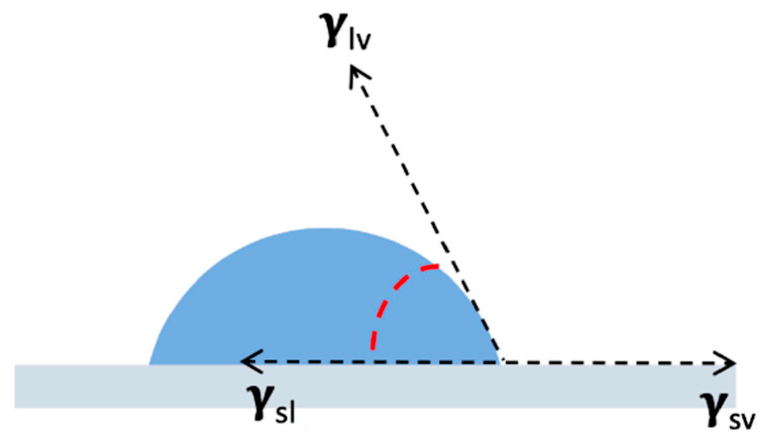
Figure 5. Interfacial tensions acting on the drop-surface